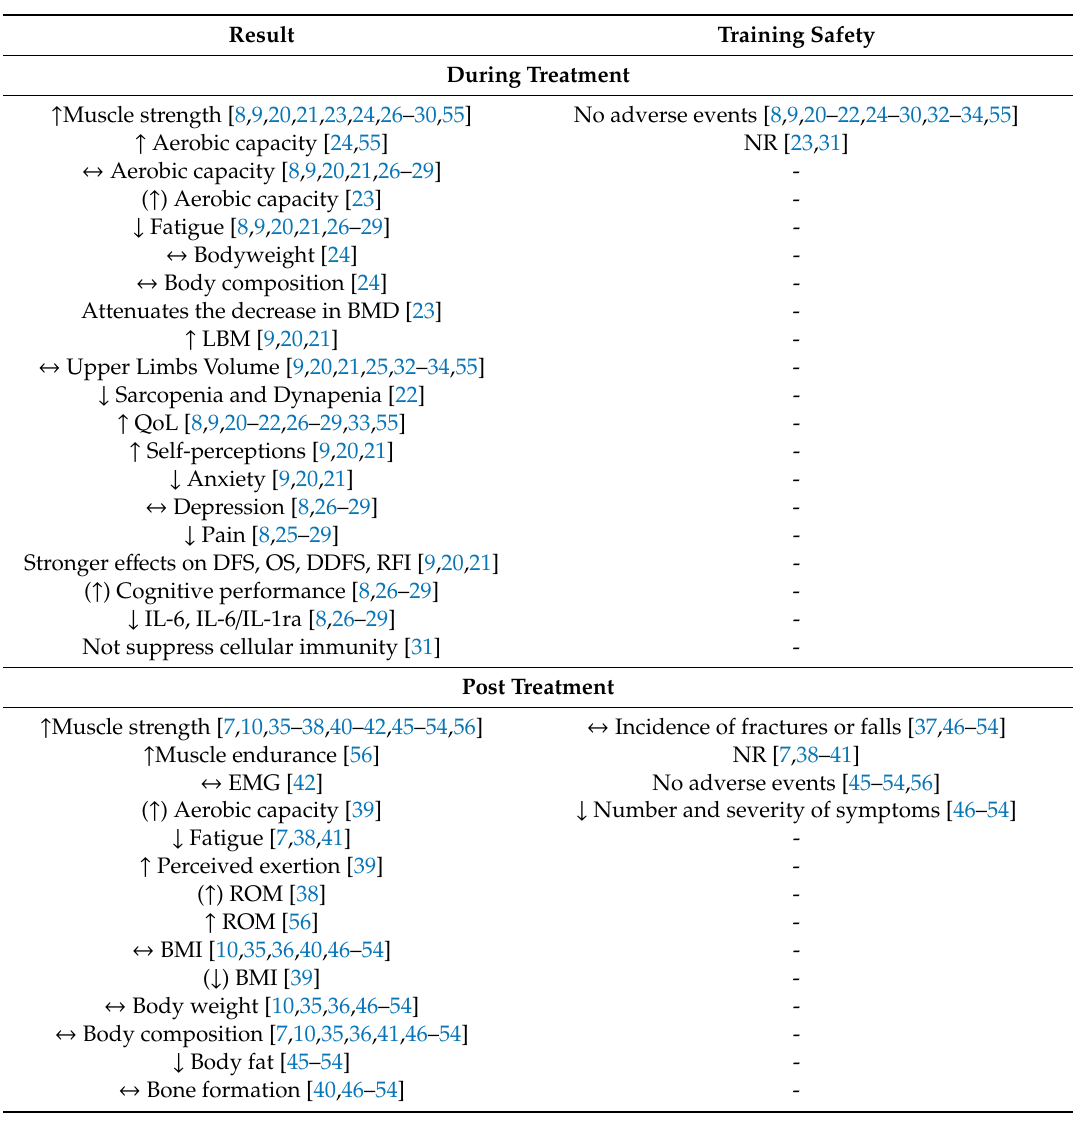
Table 10. Results and safety of resistance